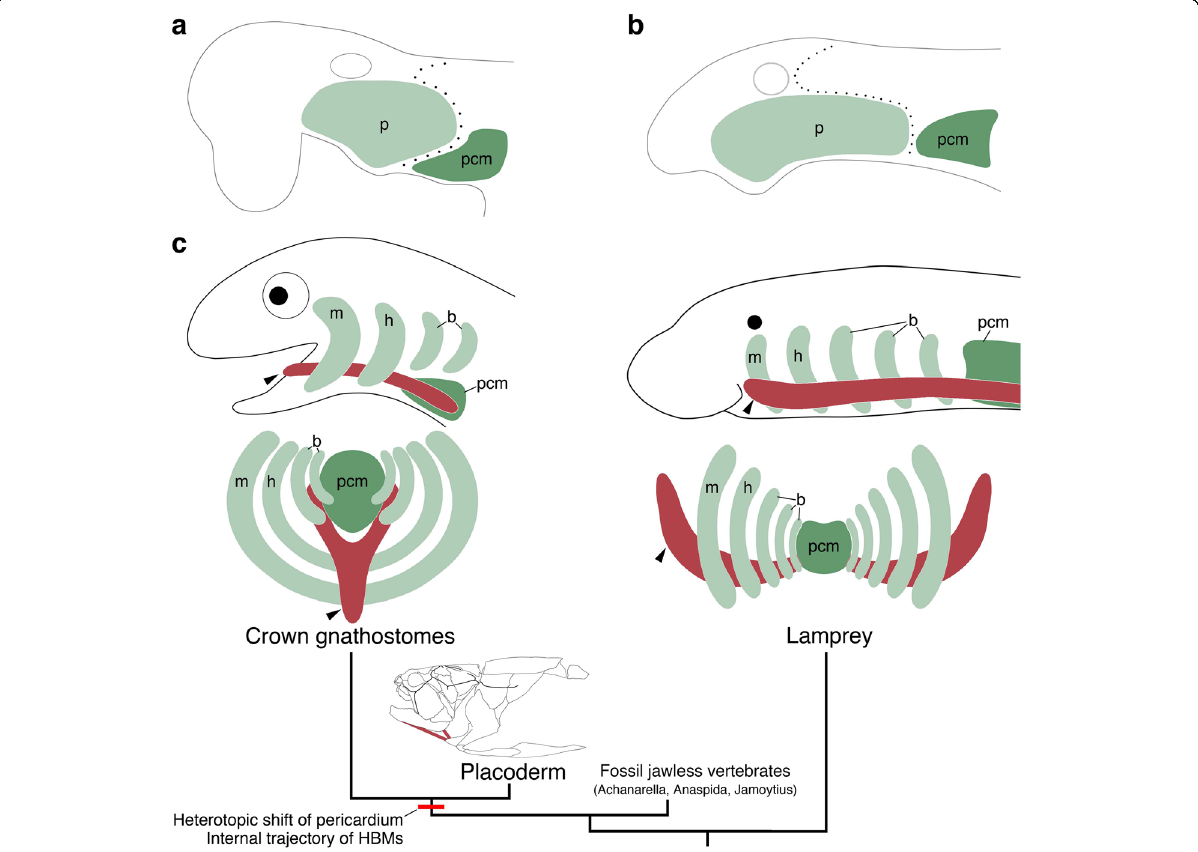
Fig. 8 Evolution of the head – trunk interface and HBMs. Schematic representations of the vertebrate head – trunk interface ( a , b ). The pericardium is located ventral to the pharyngeal arches in crown gnathostomes ( a ), whereas the pericardium is posterior to the arches in the lamprey ( b ). Dotted lines indicate the head – trunk interface. c A phylogenetic tree (modified from [63, 68]) with lateral and anterior views of HBMs and pharyngeal arches in crown gnathostomes (left) and the lamprey (right). Arrowheads indicate HBMs. Putative HBMs are shown in red lines in placoderm [67]. b, branchial arch; h, hyoid arch; m, mandibular arch; p, pharyngeal arches; pcm, pericardial